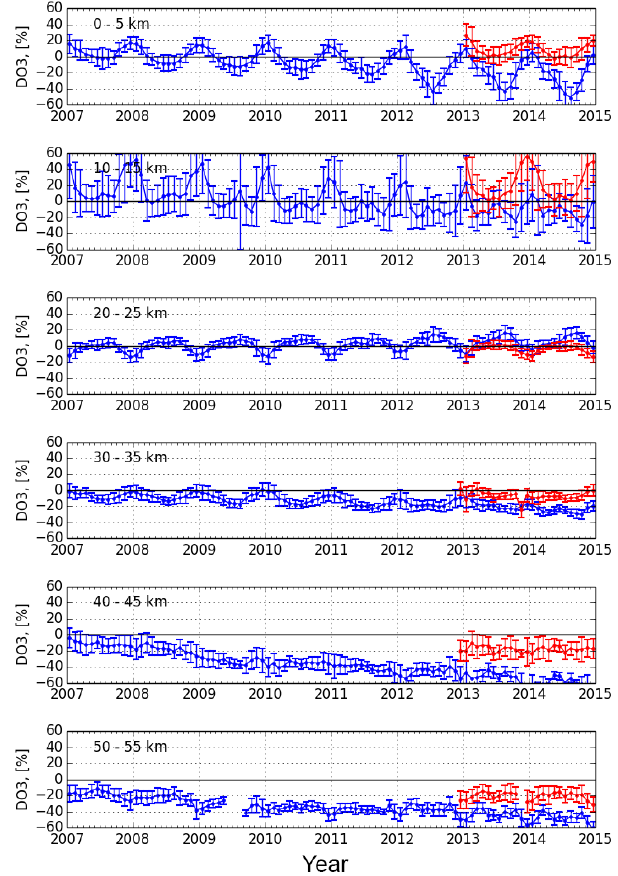
Figure 5. Time series of the relative differences between GOME- 2 ozone profiles (CR) and corresponding ground-based measure- ments. Shown are monthly mean values and their standard devia- tions. The data are averaged over all available stations at northern midlatitudes. At the three lower altitude layers, ozone sondes are used for comparison, and at the higher levels, two lidar (Hohenpeis- senberg and Haute Provence) and two microwave stations (Bern and Payerne). The blue curves are for GOME-2A and the red ones for GOME-2B. All data are smoothed, by applying the GOME-2 aver- aging kernel and a priori